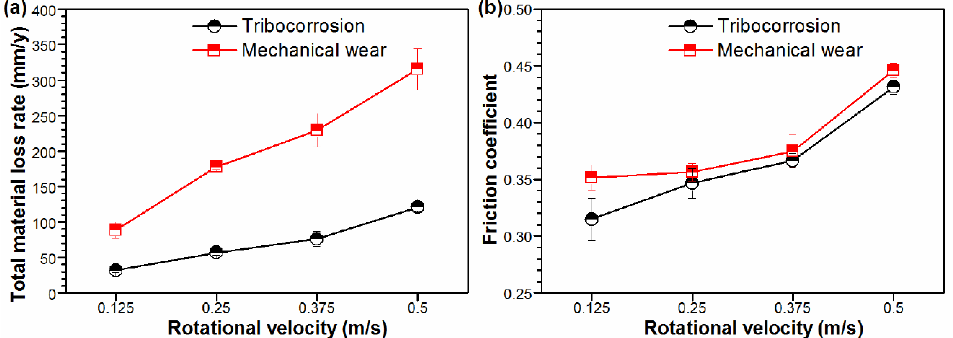
Figure 3. ( a ) Total material loss rate and ( b ) friction coefficient of Monel 400 alloy in seawater under both tribo-corrosion- and mechanical-wear conditions, with different rotational velocities ranging from 0.125 m/s to 0.5 m/s.